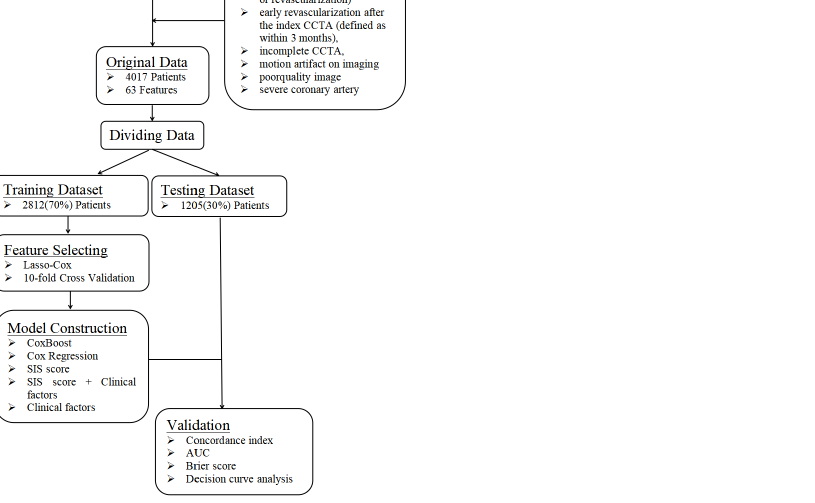
Figure 1. A flowchart about the framework of this study. The data were randomly divided into a training dataset and a testing dataset at a ratio of 7:3. The training dataset was used to build the prediction model, whereas the testing dataset was independently used to verify the effectiveness of the prediction model generated by the training dataset by computing C-index, AUC, Brier score and